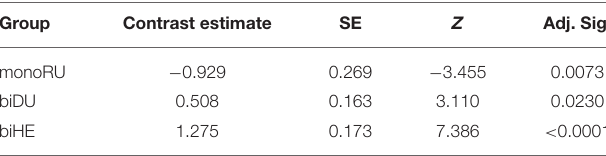
TABLE 5 | Pair-wise ACC-vs-GEN contrasts for monoRU, biDU and biHE groups.